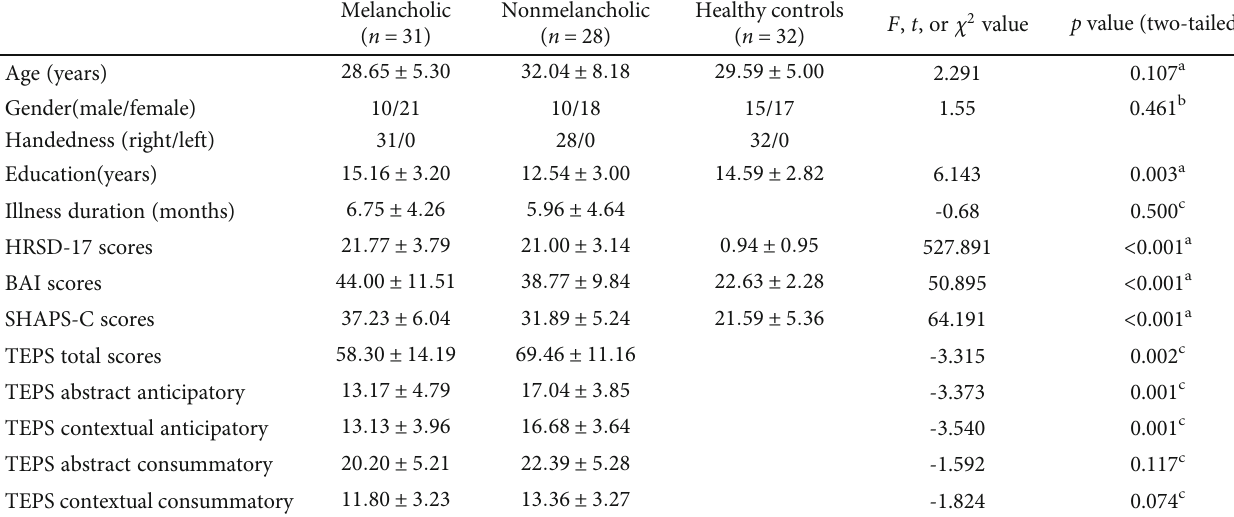
Table 1: Demographic and clinical characteristics of the participants.